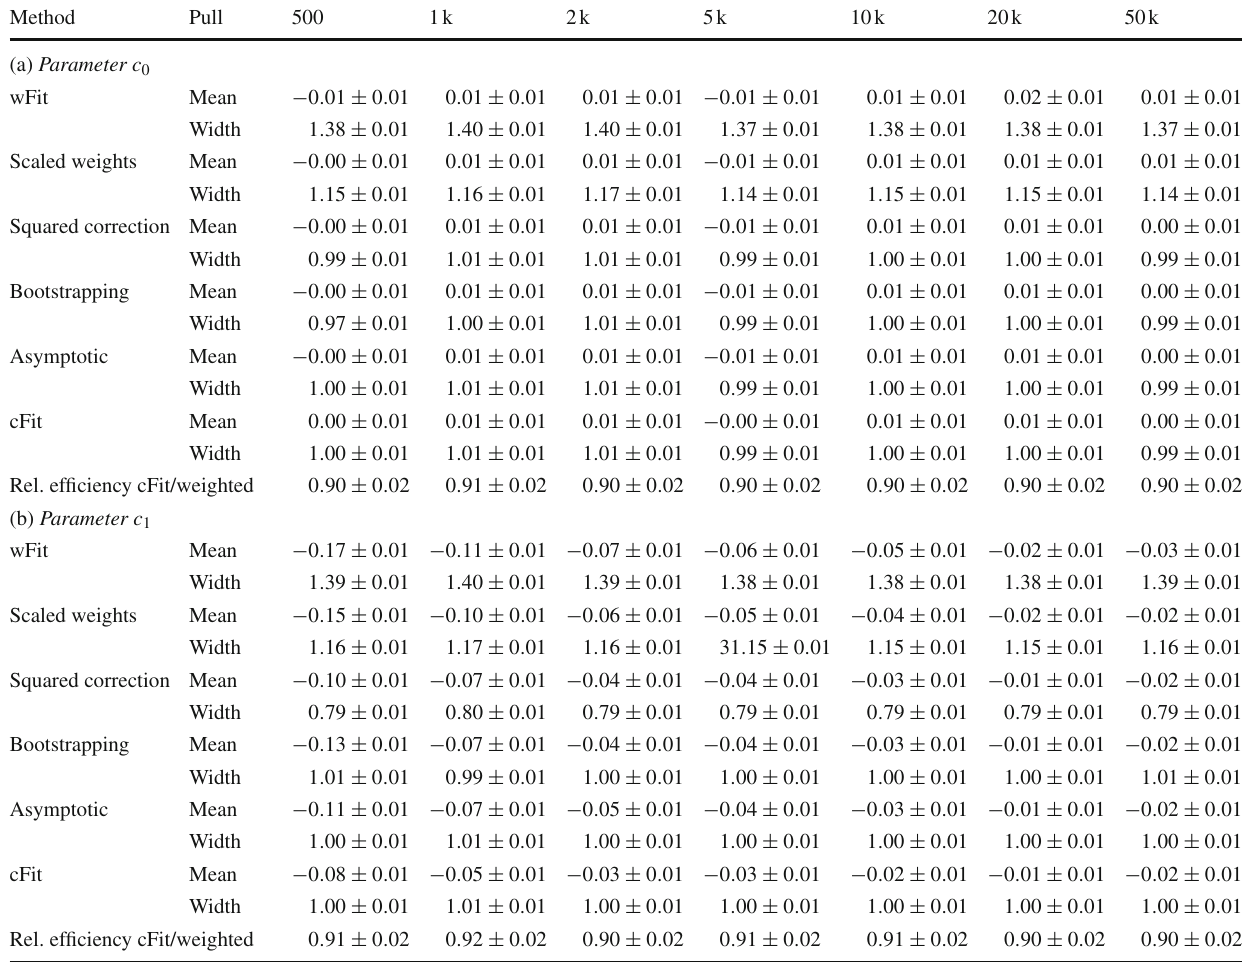
Table 2 Means and widths of the pull distribution for the different approaches to the uncertainty estimation for the efficiency correction (cid:4)( cos θ) = 1 . 0 − 0 . 7cos 2 θ , depending on the number of events. In